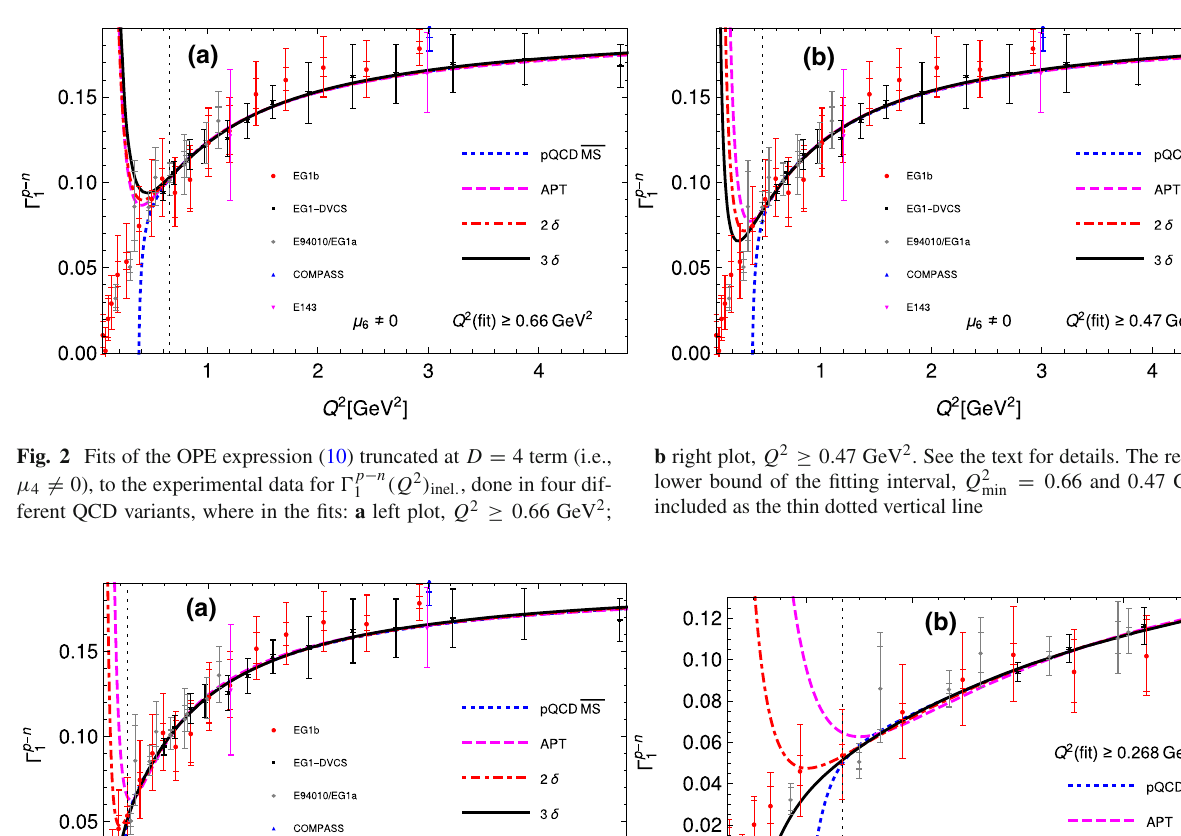
= 0 . 268 GeV 2 , min